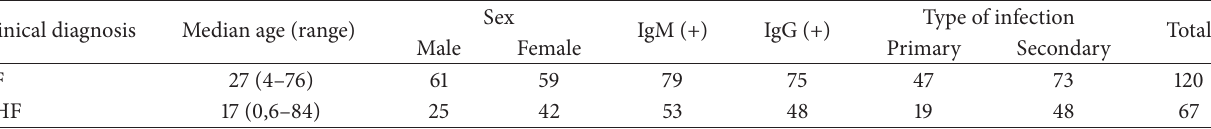
Table 1: Distribution of DENV-3 cases with regard to demographic profiles, clinical manifestation, and type of infection. Clinical diagnosis